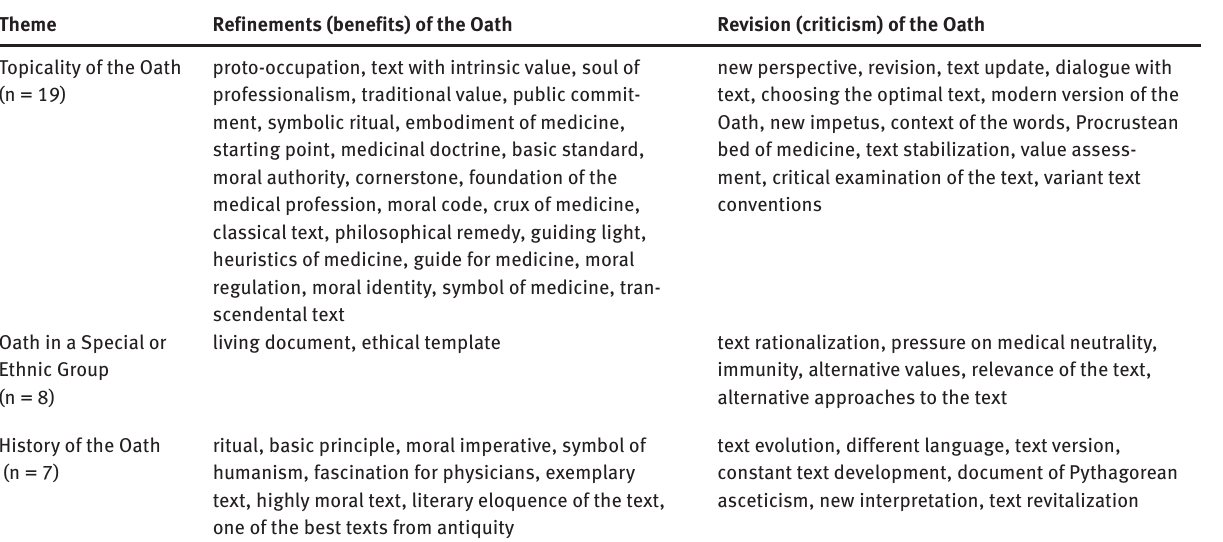
Table 2: Linguistic perceptions of the Hippocratic Oath